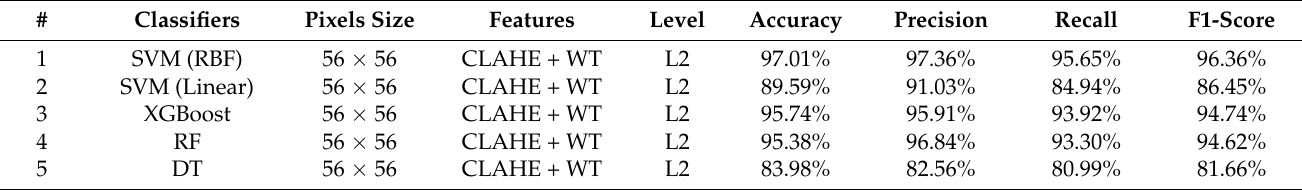
Table 9. Comparison of the results of the machine learning classifiers on version 2 of the